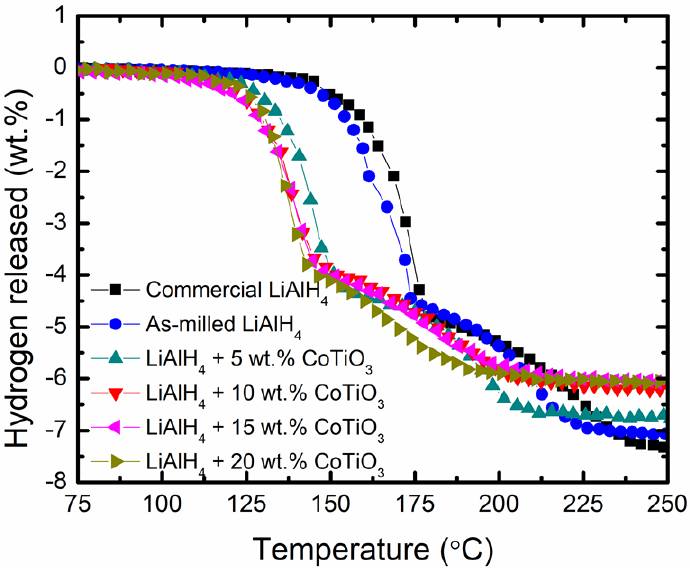
Figure 1. TPD profile of commercial LiAlH 4 , as-milled LiAlH 4 and LiAlH 4 + x CoTiO 3 ( x = 5, 10, 15 and 20 wt.%).